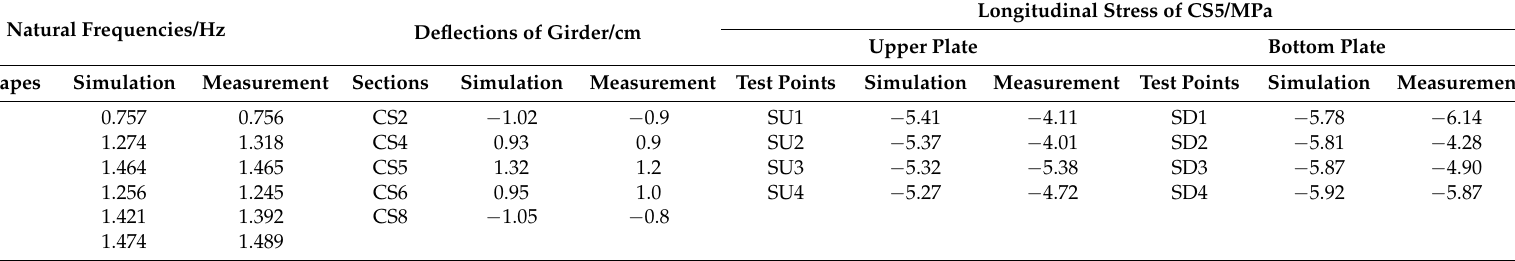
Table 1. Verification of the finite element